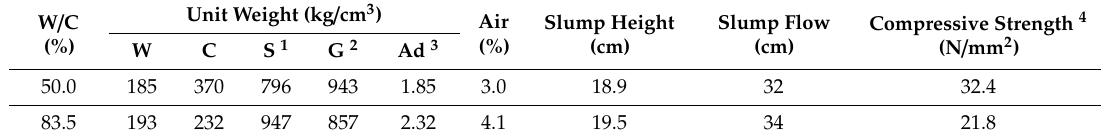
Figure 1. Specimen outline. Table 3. Mix proportion of concrete for the